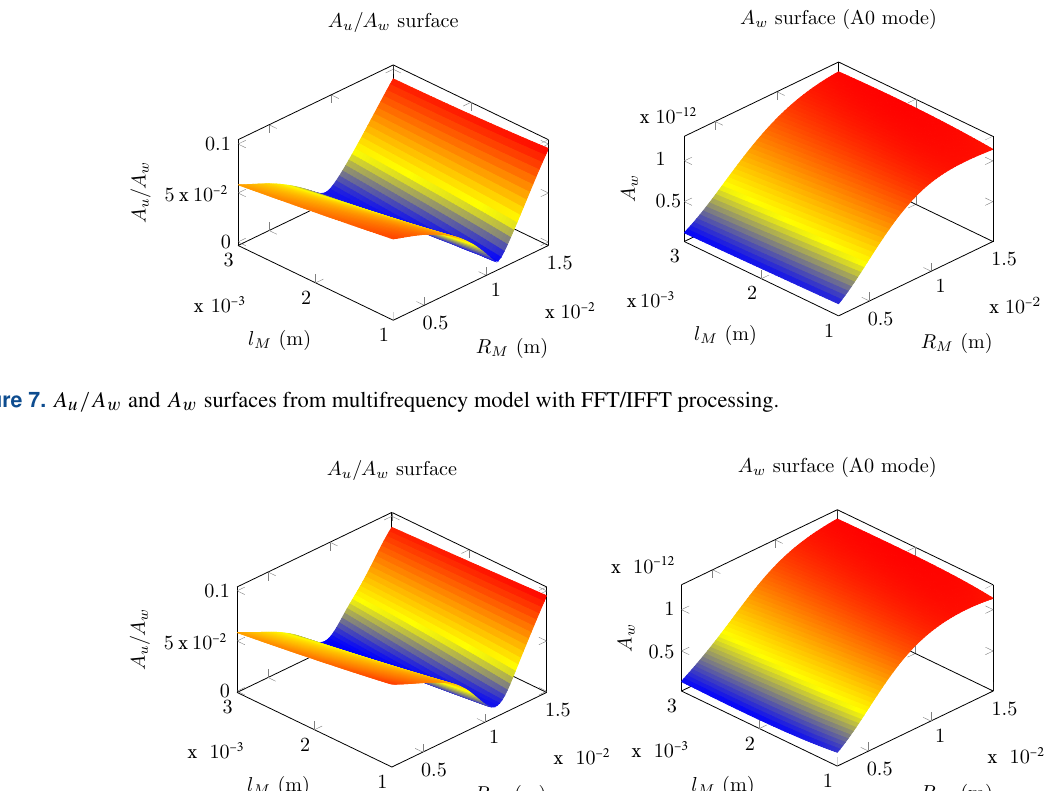
functions are predicted with the networks on a 60 × 60 grid of the design variables, as shown in Fig. 9. The values of A u and A w are also scaled in the same way. From the figure, we can see that the multilayer networks trained with the LM algorithm approximate the surfaces better, compared to the networks trained with the basic BP